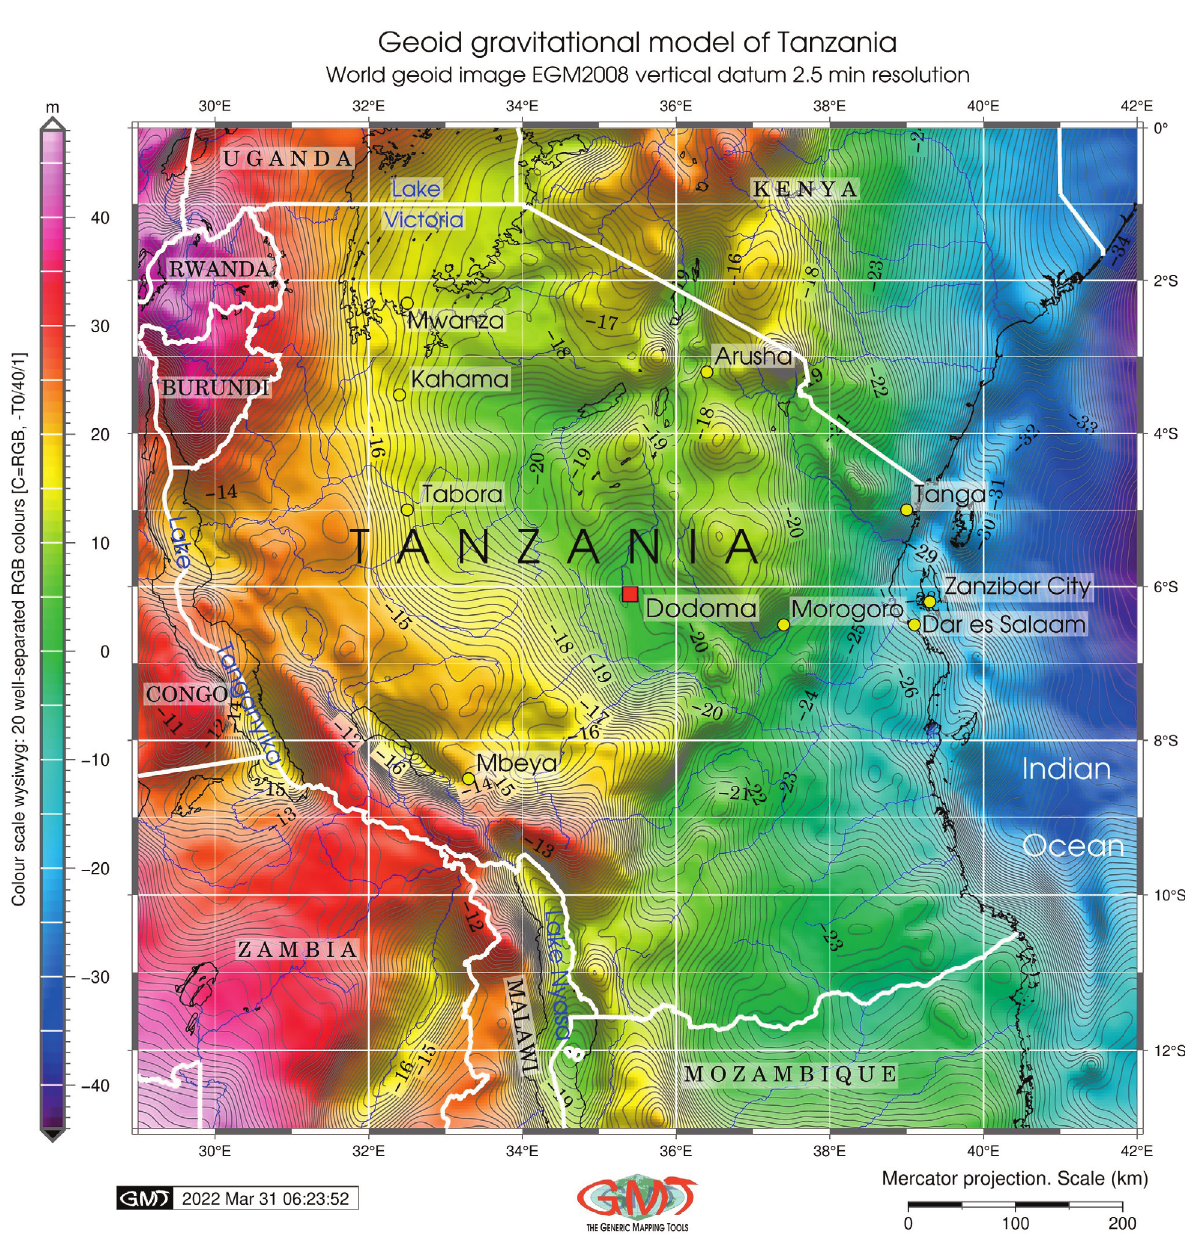
Fig. 4. Geoid gravitational model of Tanzania. Data: EGM-2008. Map source: elaborated by the